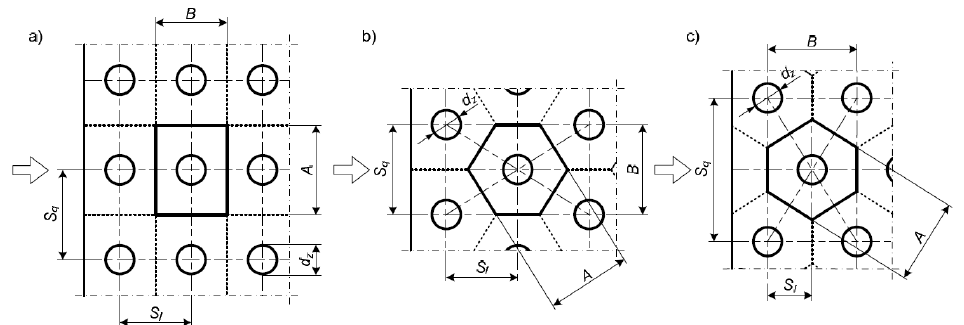
Figure 3. Schematic picture of different elementary fins: ( a ) rectangular where S q > S l ; ( b ) hexagonal where S l ≥ 0.5 ∗ S q ; ( c ) hexagonal where S l < 0.5 ∗ S q